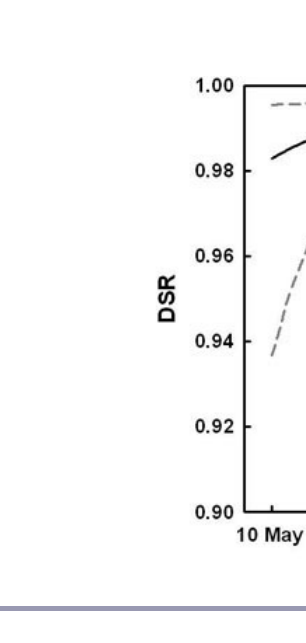
Fig. 3. Daily survival rate (DSR), and 95% confidence interval, as a function of date, averaged across all year by treatment combinations for nests 14 days of age and median water depth of 31 cm, for American Coot ( Fulica Americana ) nests at Grays Lake, Idaho during